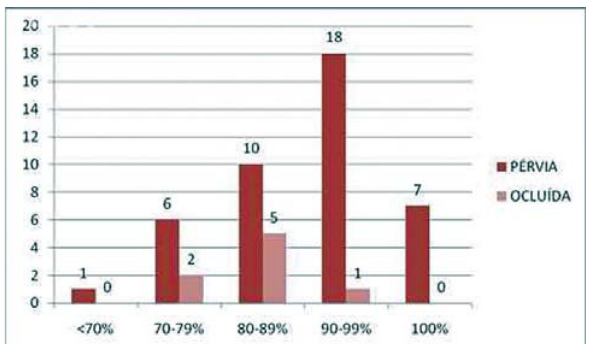
Fig. 5 - Evolução da perviedade dos enxertos de AR, quanto à lesão obstrutiva da artéria coronária revascularizada – grupo anastomose proximal na aorta